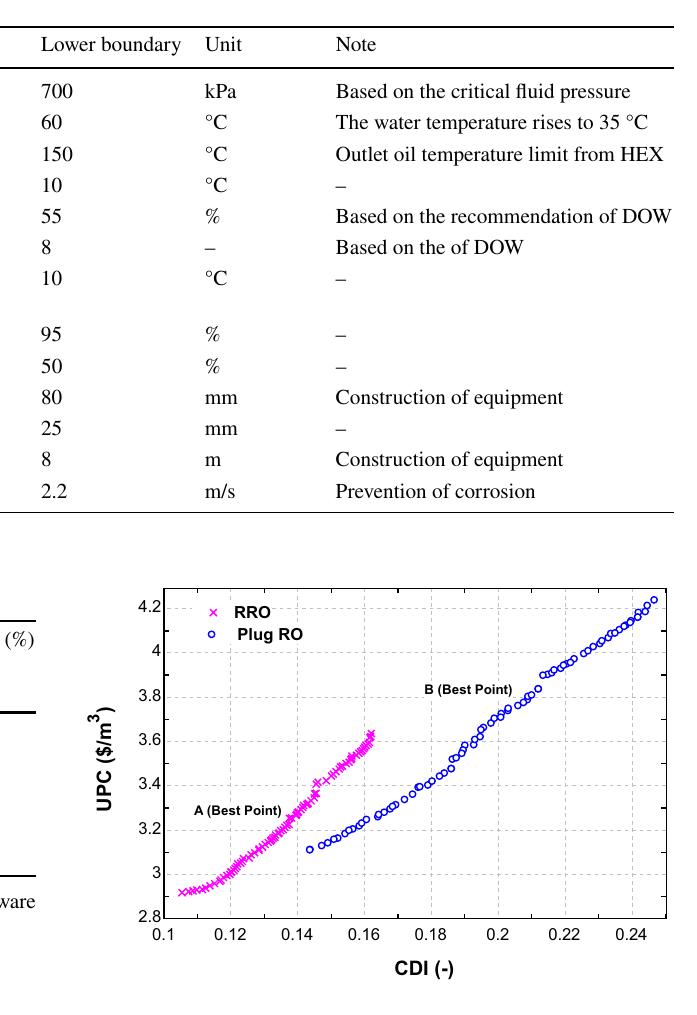
Fig. 4 Pareto curves obtained from RO and RRO system